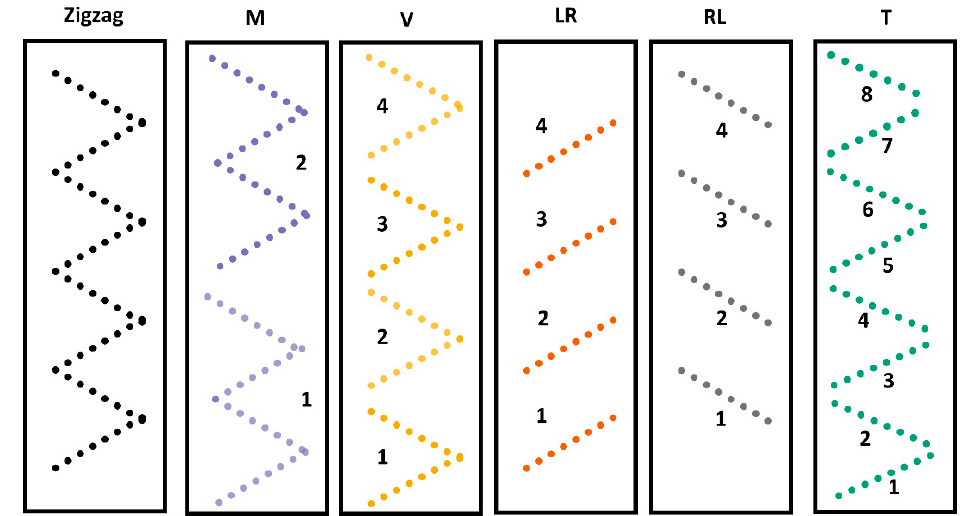
Figure 2. Schematic representation of the different walking patterns evaluated: Zigzag ( ● ); M = M- shape ( ● ), V = V-shape ( ● ); LR = left to right transects ( ● ); RL = right to left transects ( ● ); T = individual transects ( ● ). Numbers indicate the different repetitions within each pattern evaluated.